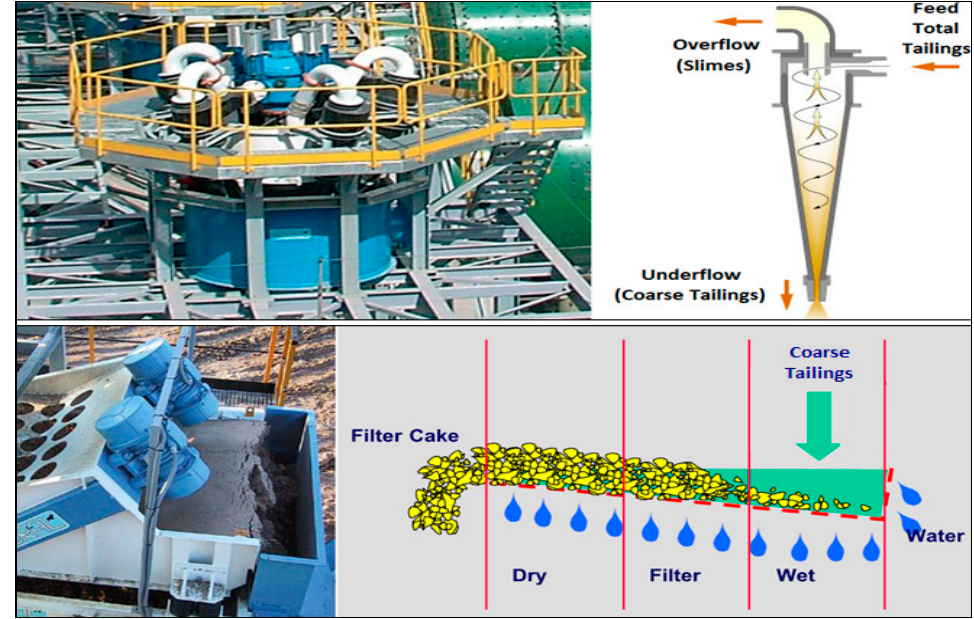
Figure 3. Schematic View of Dewatering Process on Hydrocyclone (HC) + Horizontal Vibratory Screen (HVS) (Adapted figure from [37]).